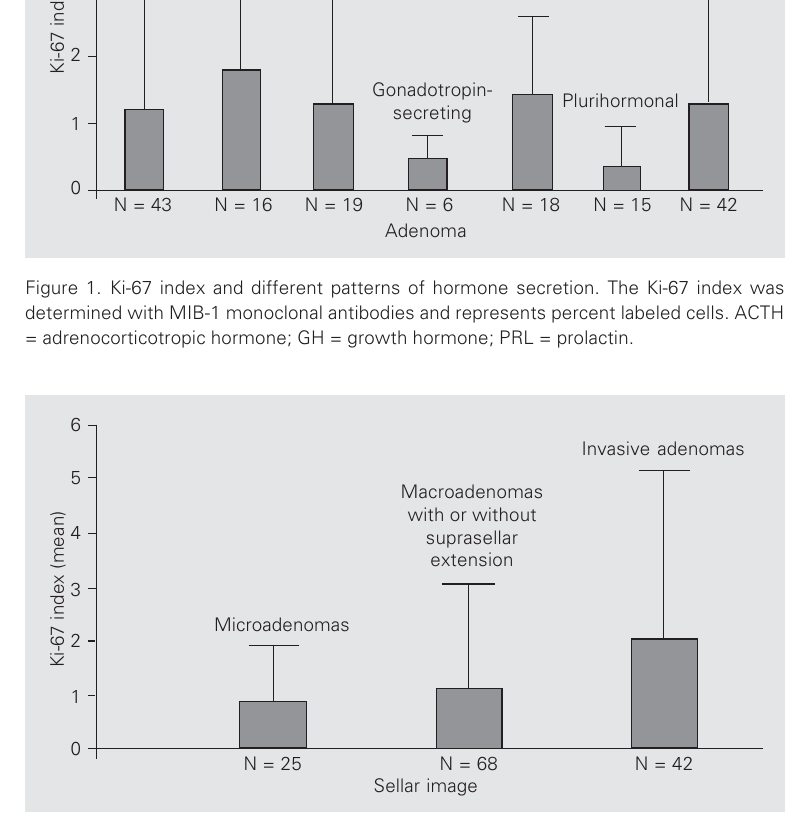
Figure 2. Ki-67 index and volume and extension of pituitary adenomas. The Ki-67 index was determined as described in the legend to Figure 1. The number of microadenomas includes 6 cases that were normal according to image analysis, but were positive according to tissue